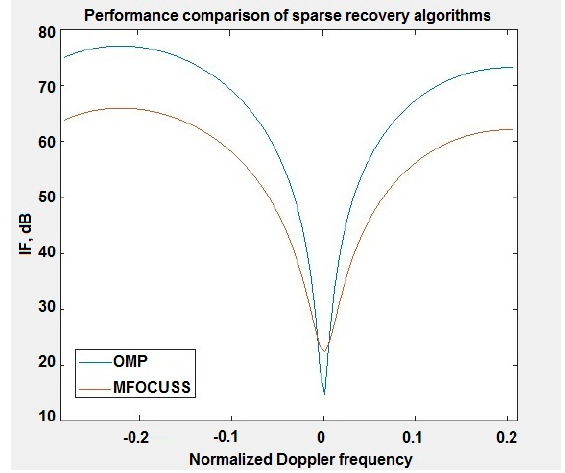
Figure 6. Values of signals received by the MIMO radar array as a function of range after STAP processing.